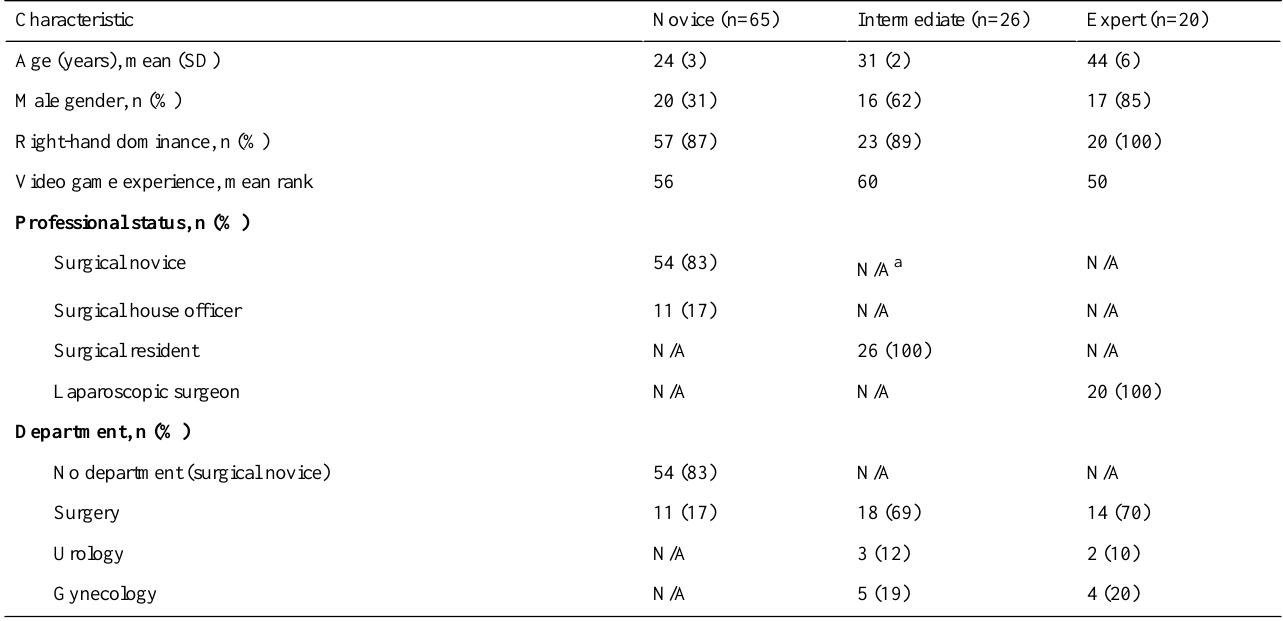
Table 1. Demographics of the participant groups.